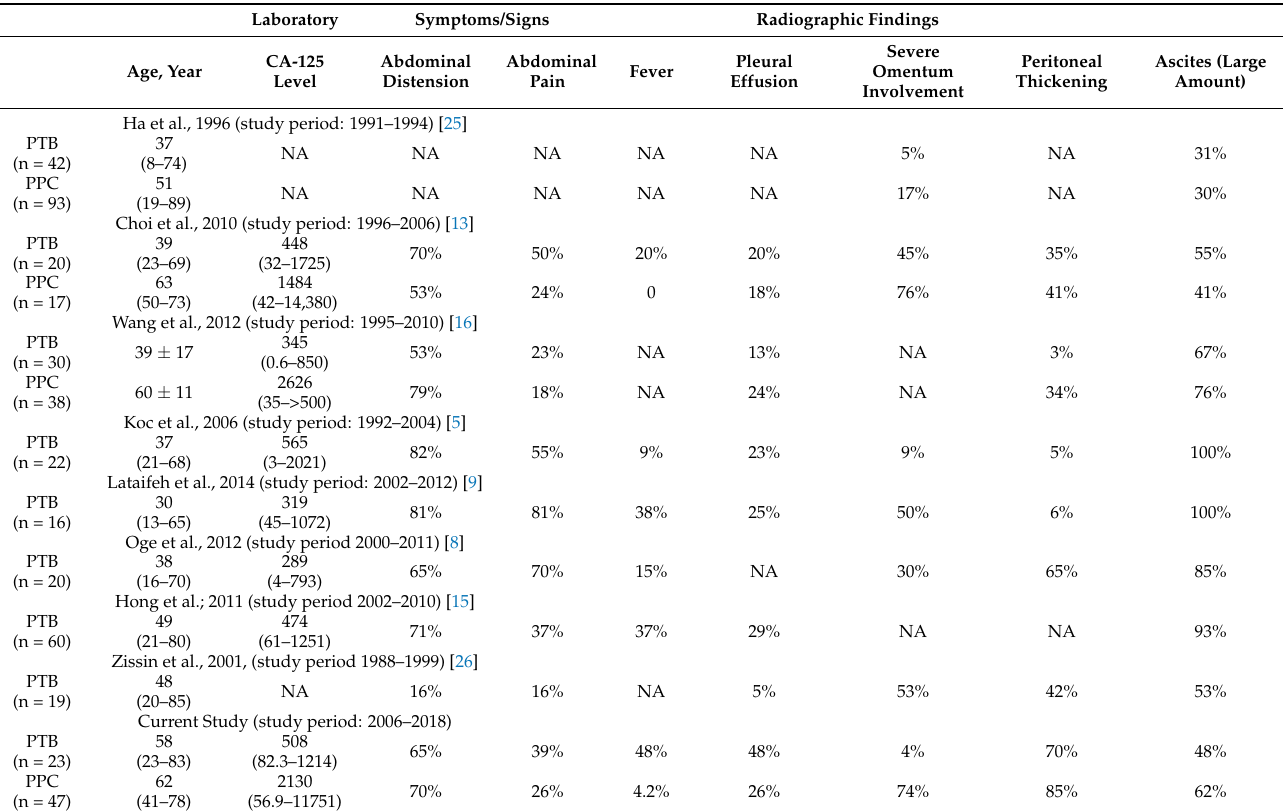
Table 4. List of clinical presentations in PTB and PPC from literature